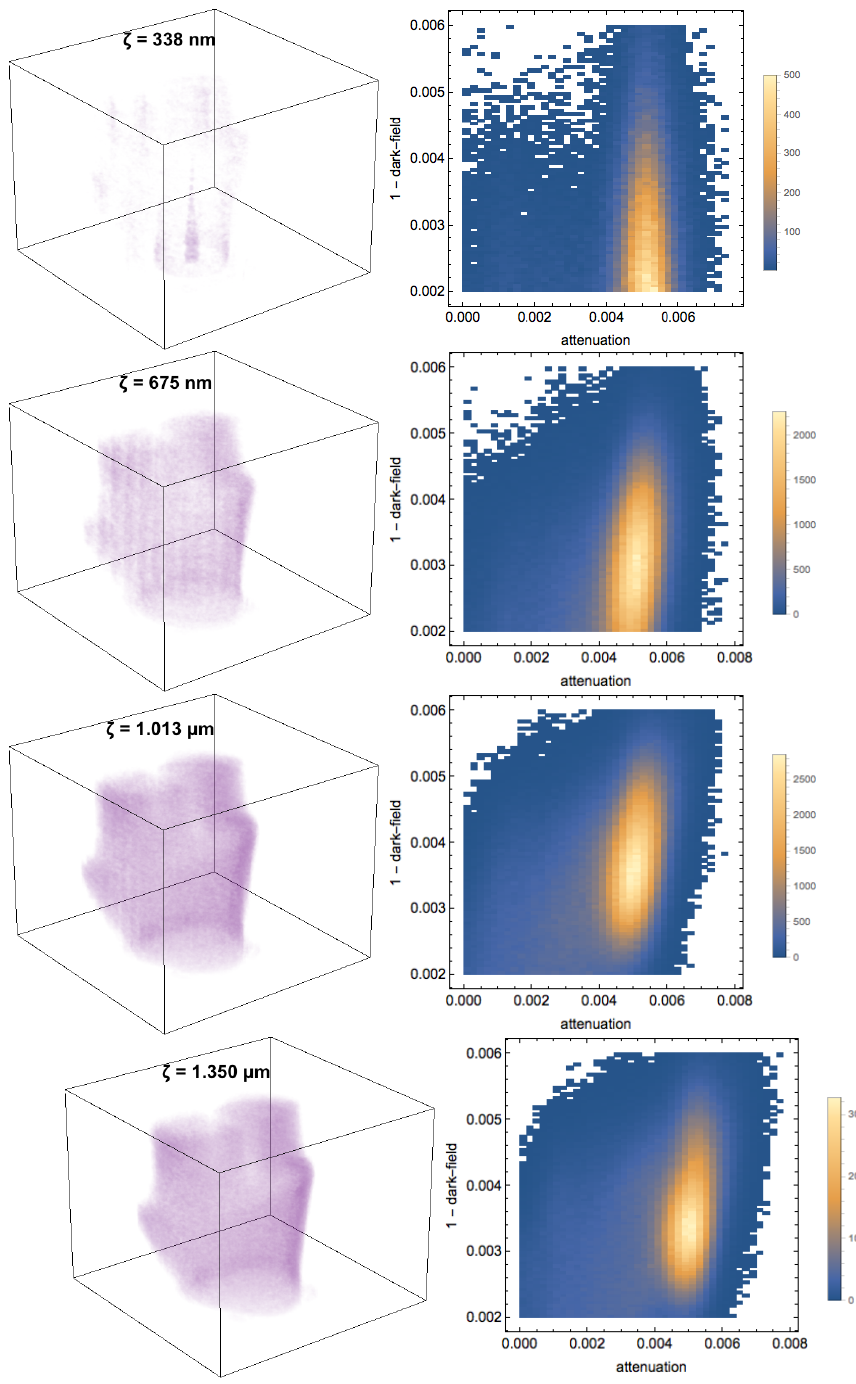
Figure 6. Dark-field volumes and histograms of the quadratic and cubes at ξ = 338 nm, ξ = 675 nm, ξ = 1.013 µ m, and ξ = 1.350 µ